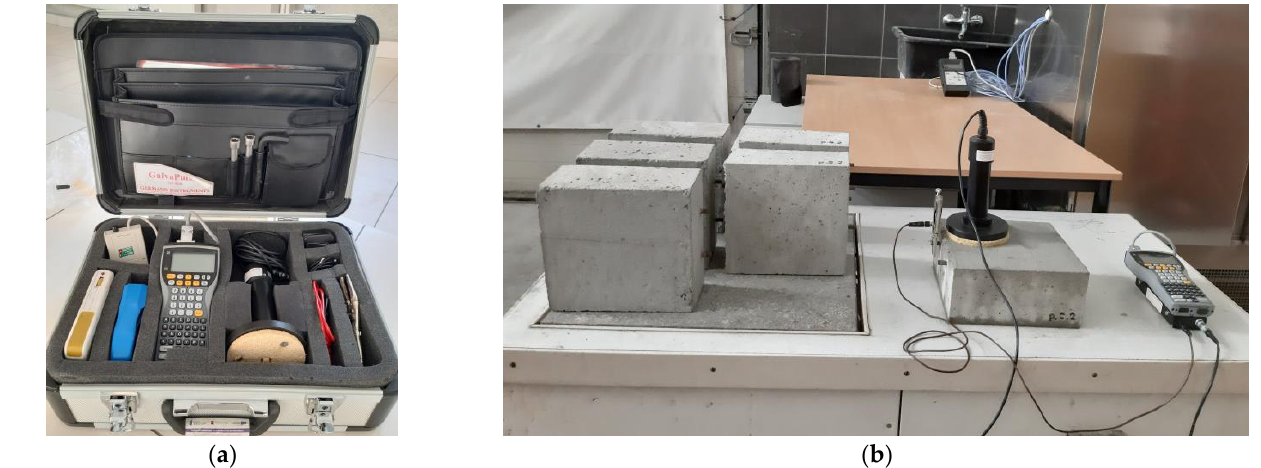
Figure 2. A photo of the test stand: ( a ) elements of the GP-5000 GalvaPulse TM set, ( b ) scheme of connection of the set with the reinforcement in the tested specimen.